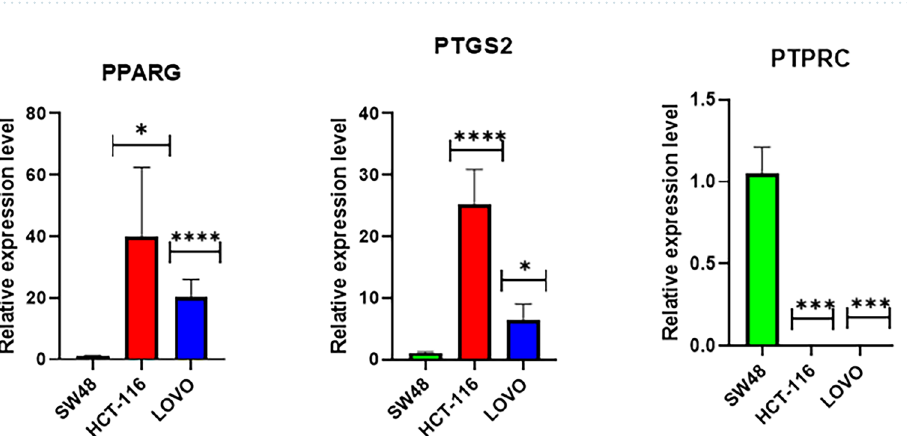
Figure 8. Quantitative real-time PCR validated three dysregulated genes in association with KRAS mutation. Expressions of PPARG and PTGS2 were significantly elevated in KRAS-mutant cell lines (HCT-116 and LoVo) compared non-mutant cell line (SW48). The expressions of PTPRC in SW48 compared with other cell lines was